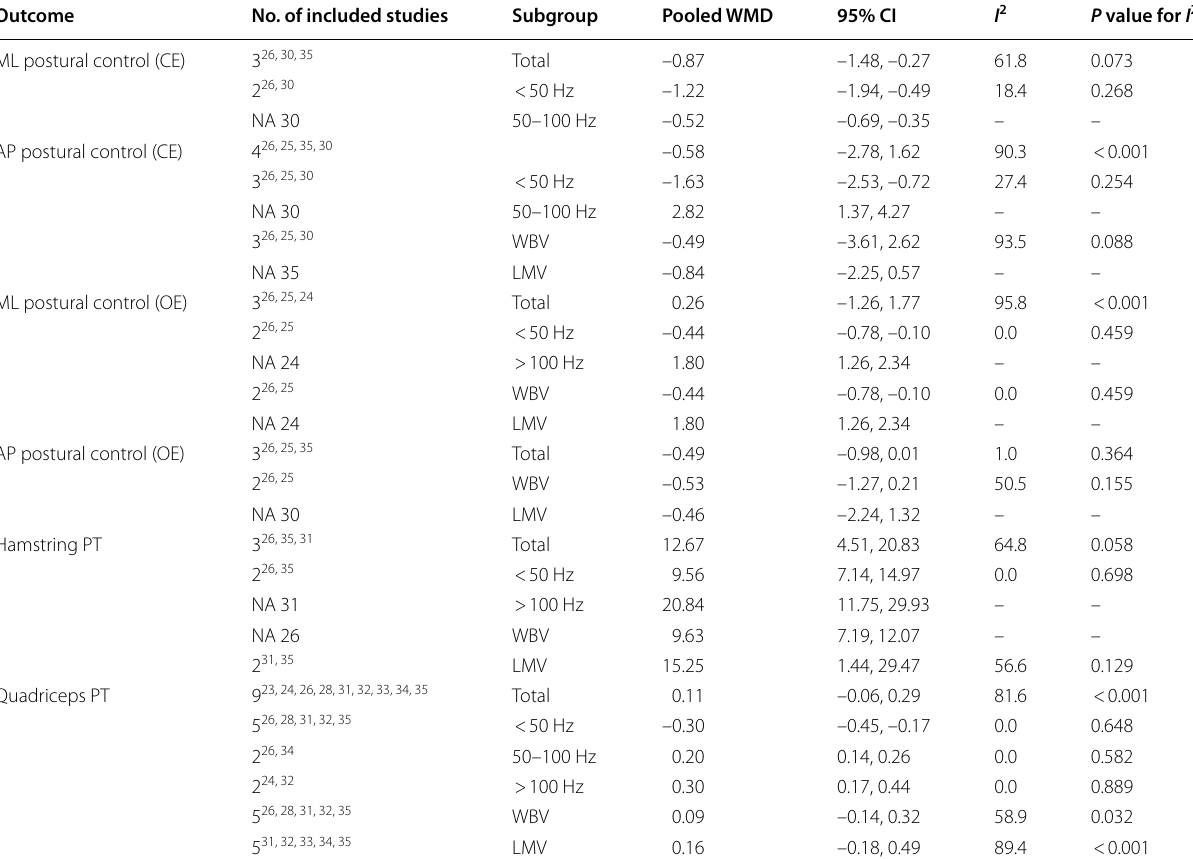
PT peak torque, AP anterioposterior, ML mediolateral, CE closed-eye, OE open-eye, NA not applicable